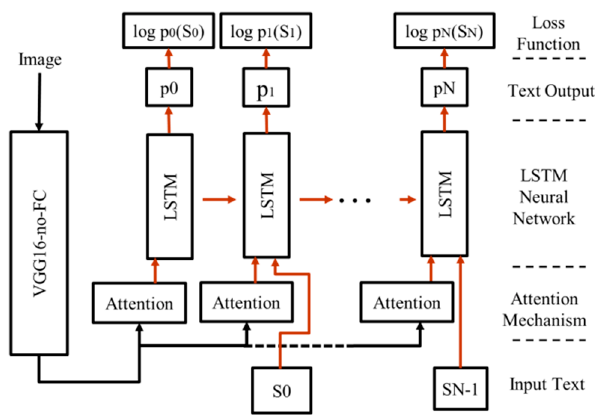
Figure 4. Color recognition flowchart.